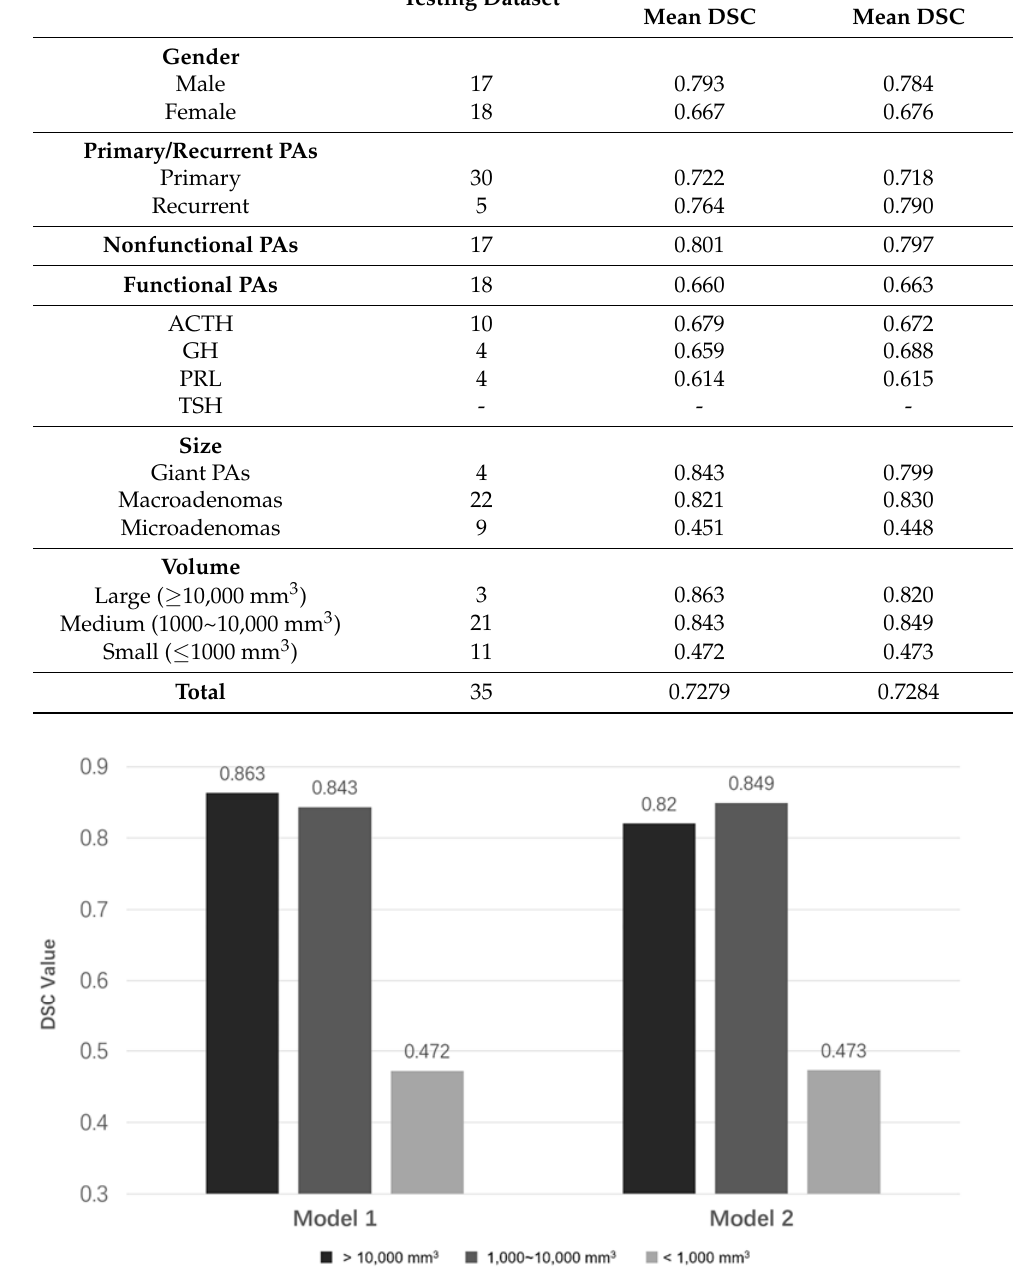
Figure 4. Performances of the models in different PA groups with different volumes in the testing dataset.